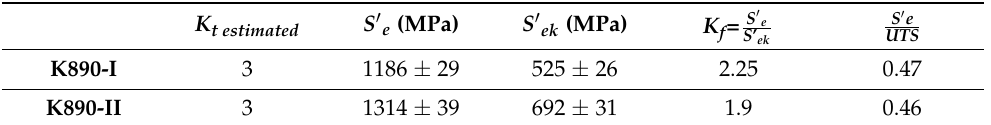
Table 4. Results of bending fatigue tests carried out on notched S’e k and unnotched specimens S’e; fatigue strength at 10 7 cycles for a failure probability of 50%. K t is the theoretical stress concentration factor; K f is the fatigue notch